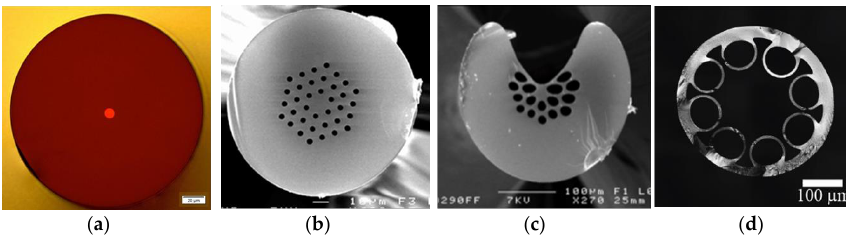
Figure 7. Chalcogenide fiber designs: ( a ) Step index fiber (courtesy of IRflex); ( b ) Single-mode microstructured fiber (courtesy of SelenOptics); ( c ) Exposed core fiber, reproduced with permission from [173], copyright Elsevier, 2013; ( d ) Hollow core fiber, reproduced with permission from [174], copyright OSA, 2016.